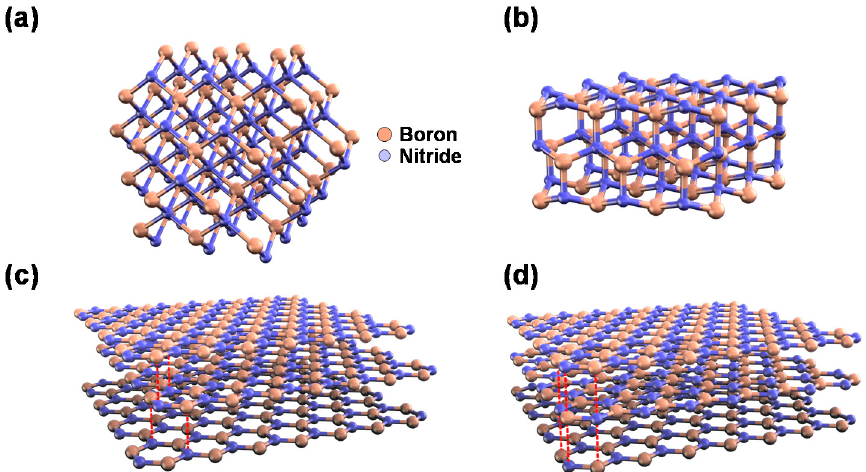
Figure 1. Schematic crystal structures of ( a ) cubic boron nitride (cBN), ( b ) wurtzite boron nitride (wBN), ( c ) rhombohedral boron nitride (rBN), and ( d ) hexagonal boron nitride (hBN).